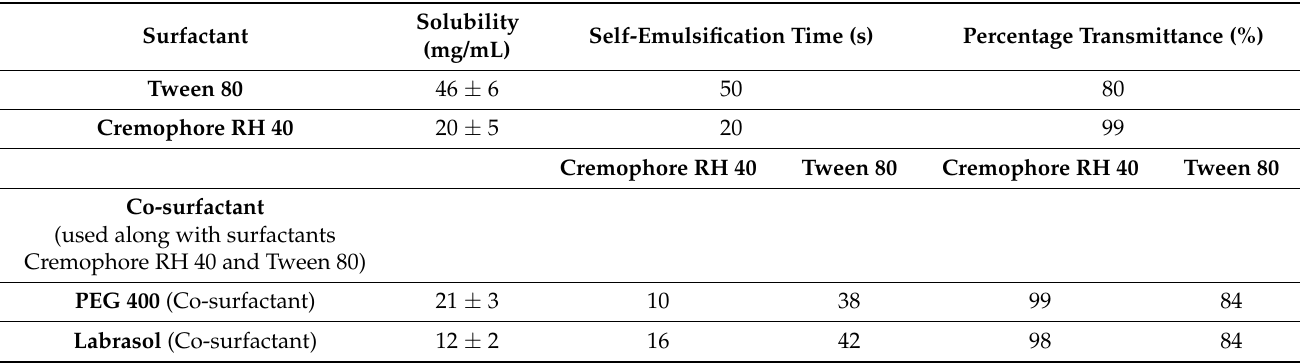
Table 1. Finasteride solubilizing capacity and emulsification ability of surfactants and co-surfactants. The results are shown as mean ± S.